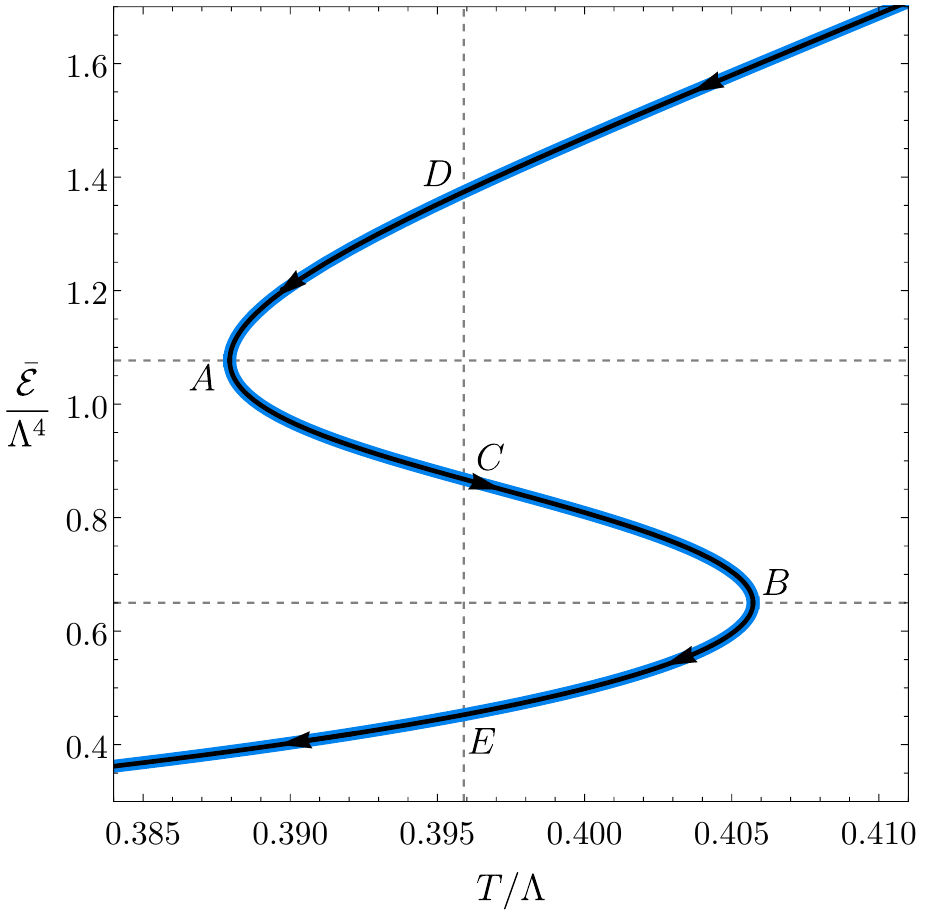
Figure 31 . Phase diagram in the microcanonical ensemble for a length ˆ L such that ˆ L < ˆ L K < ˆ L ˆ L Σ 1 < Σ 2